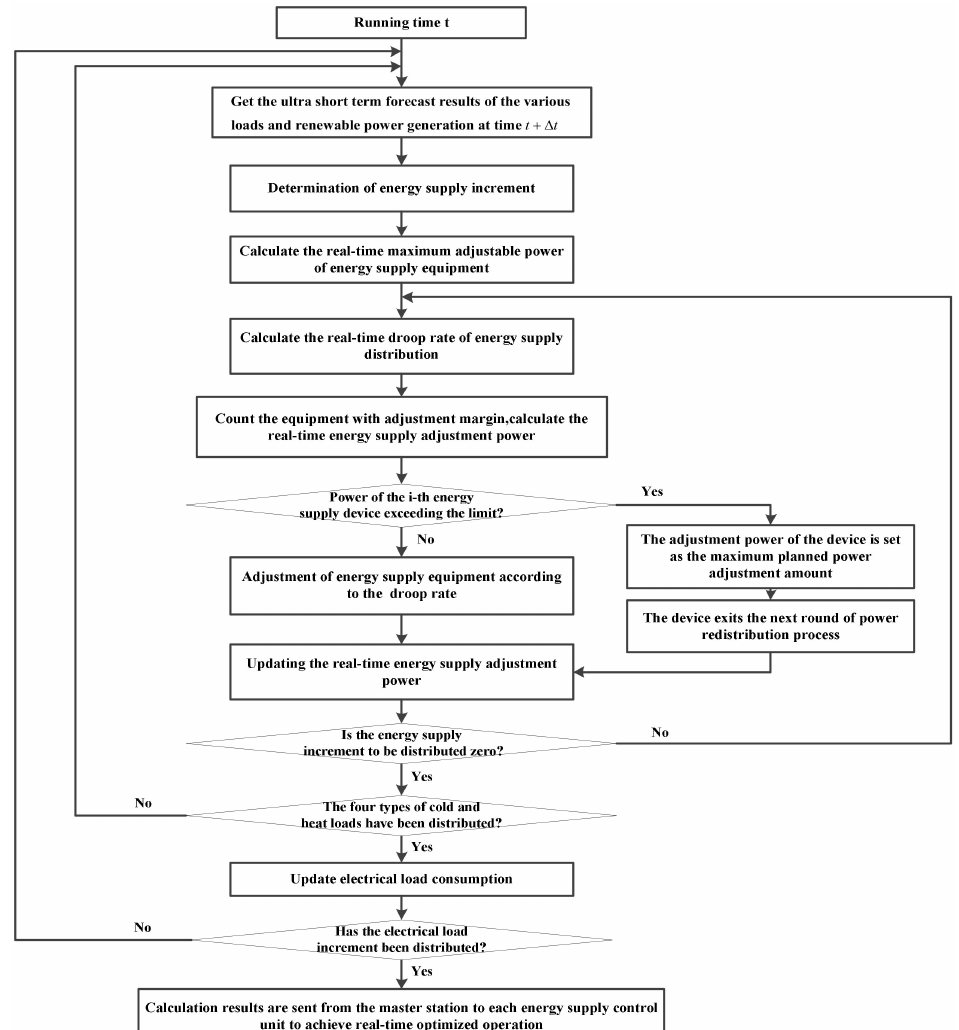
Figure 6. Flow chart of real-time operation error correction for integrated energy